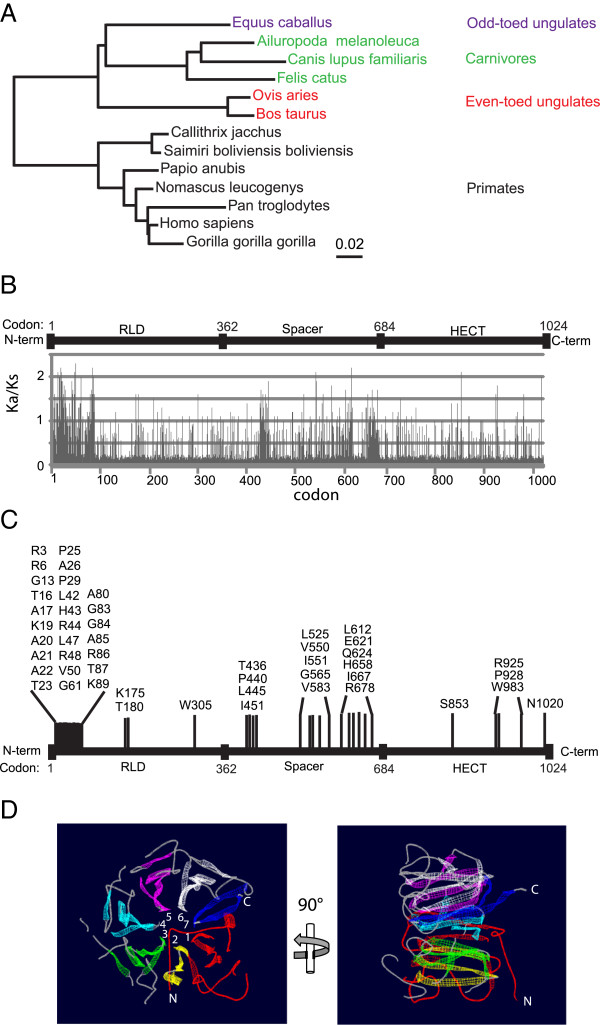
Positive evolutionary selection analysis of HERC5. A, Neighbor-joining phylogenetic tree for progressive alignment of 13 different HERC5 species using constraint-based alignment tool (COBALT) for multiple protein sequences (Additional file 1: Figure S4). Branch lengths are proportional to the amount of inferred evolutionary changes. B and C, Selecton analysis for positive selection was performed using HERC5 sequences from human, chimpanzee, gorilla, marmoset, baboon, squirrel monkey, gibbon, horse, panda, sheep, cow, dog and cat. Evolutionary analysis for positive selection in HERC5 using various models of evolution where M8 and MEC allow for sites to evolve under positive selection and M7 and M8a models do not. (B) A plot of the Ka/Ks ratio at each codon in an alignment of HERC5 coding sequences is shown. Codons with Ka/Ks ratios >1 indicate positive selection, =1 neutral selection and <1 purifying selection. C, A plot showing the results of a Bayesian analysis approach to identify sites where Ka/Ks >1, mapped to the different HERC5 domains. Shown are the sites where Ka/Ks >1.5 and the 95% confidence interval is larger than 1; hence considered statistically significant. D, The HERC5 RLD was modeled using SWISS-MODEL (Swiss Institute of Bioinformatics: http://swissmodel.expasy.org/) and visualized and colored using DeepView/Swiss-PDBViewer, v4.0.1. The region corresponding to amino acids 2–103 is colored red. All other colors are arbitrary and used to highlight the different blades of the β-propeller structure. The inset numbers identify the different blades. “N” and “C” denote the amino- and carboxyl-termini respectively.